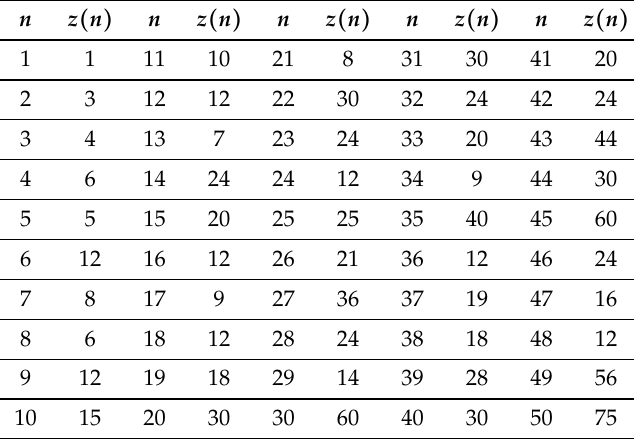
Table 1. Values of z ( n ) for n from 1 to 50.